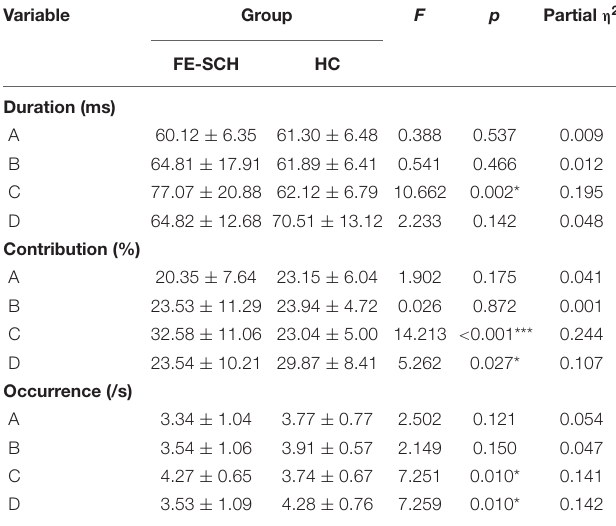
TABLE 2 | Post hoc univariate test results for the three parameters of microstate classes (Mean ± SD). Variable